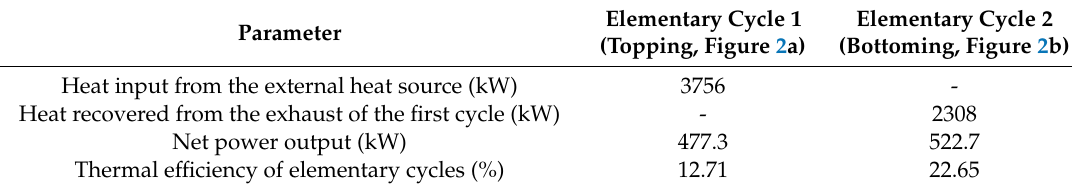
Table 3. Thermal efficiency of the two elementary thermodynamic cycles that compose the single flow split with dual expansion s-CO 2 power cycle.